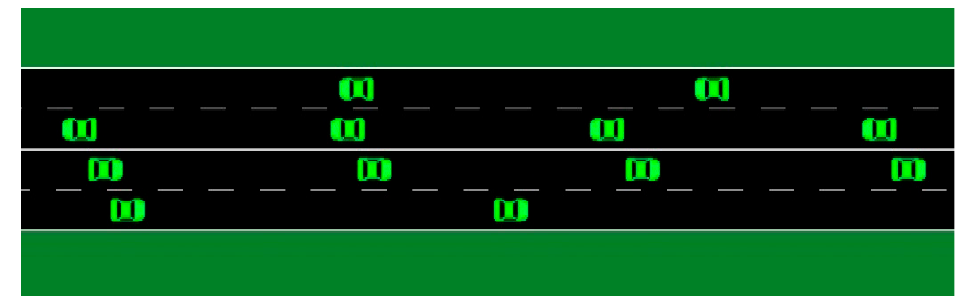
Figure 8. SUMO highway Figure 8 . SUMO highway scenario .